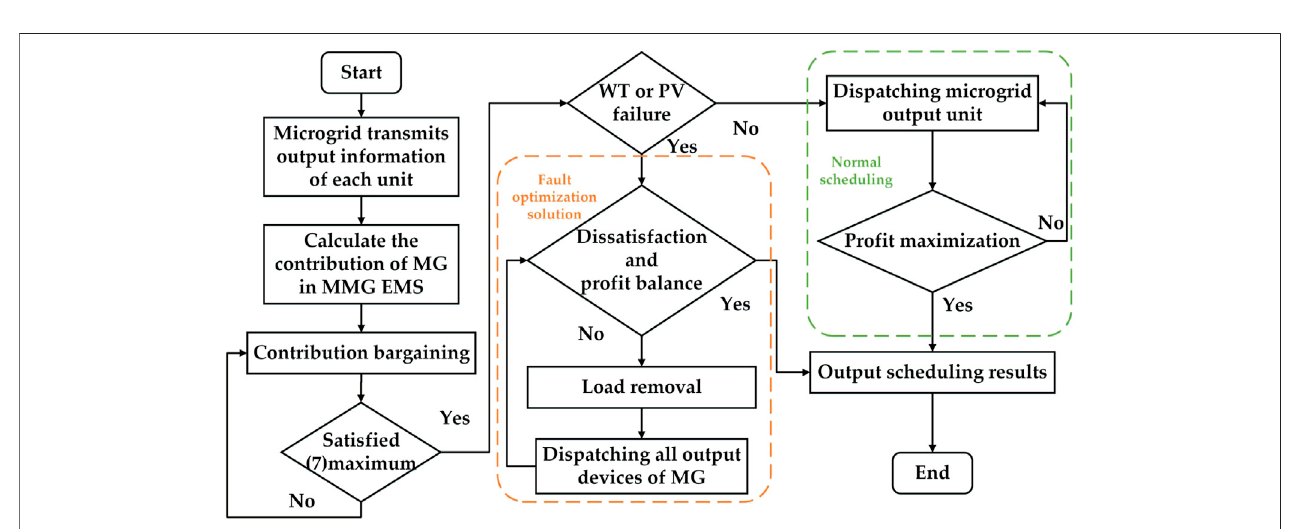
FIGURE 3 | Optimization solution fl ow